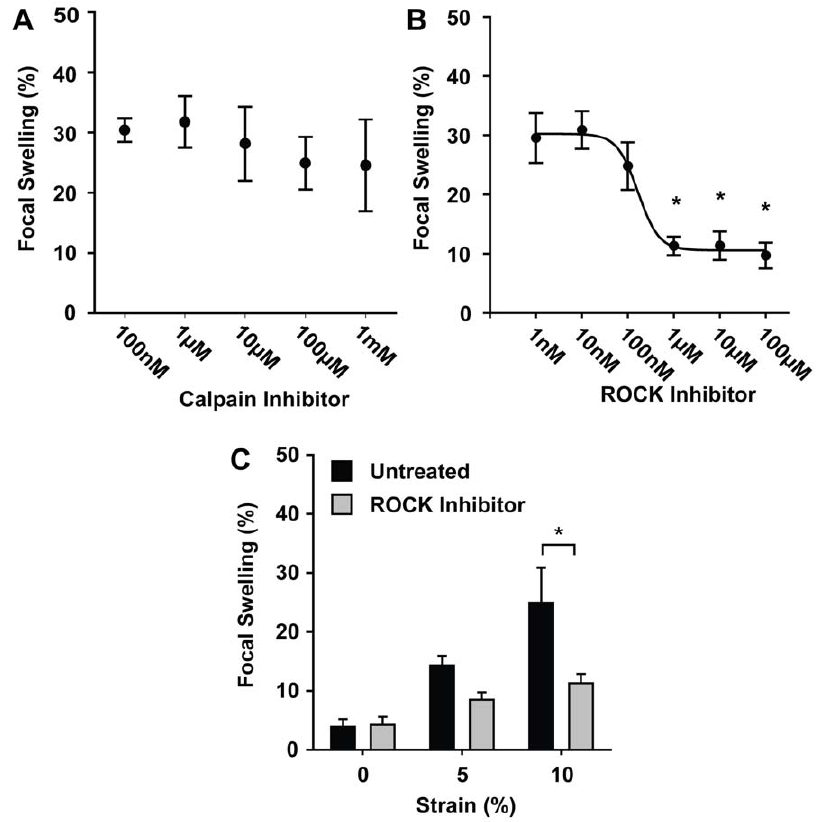
Figure 4. Pharmacological inhibition of secondary injury pathways may reduce neuronal injury. ( A ) Immediate administration of a Calpain inhibitor MDL 28170 following 10% stretch of neurons seeded on PLL substrates was unable to reduce the percentage of injured neurons 10 minutes later ( n $ 4). ( B ) However, immediate application of a ROCK inhibitor, HA-1077, was able to reduce neuronal injury in a dose dependent manner ( n $ 5). ( C ) Decreases in injury were observed at both 5% and 10% strain magnitude ( n $ 5). All bars SEM for all panels, * p ,